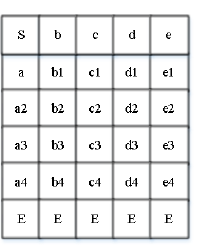
Figure 5. One-frame hand spatial data